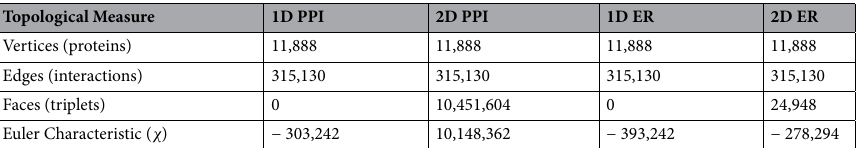
Table 1. Topological characteristics of 1D and 2D PPI network models. 1D and 2D network models were compared in the STRINGdb PPI network (PPI) and a random Erdős-Rényi (ER) network with the same number of vertices and